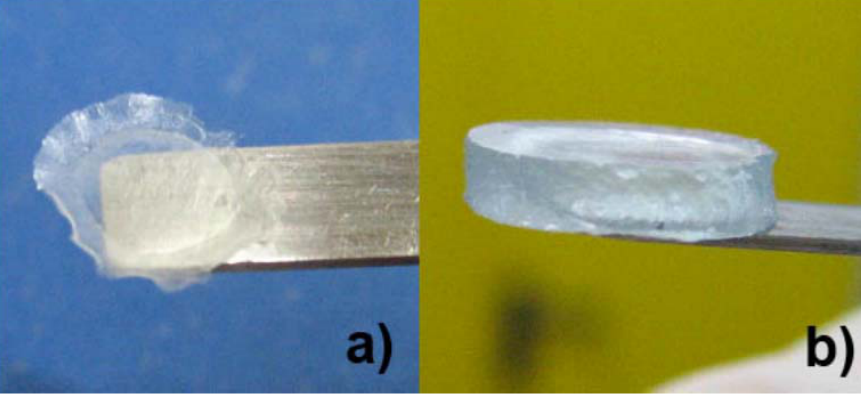
Figure 8. ( a ) Dried state of hC; and ( b ) swollen state of hC.